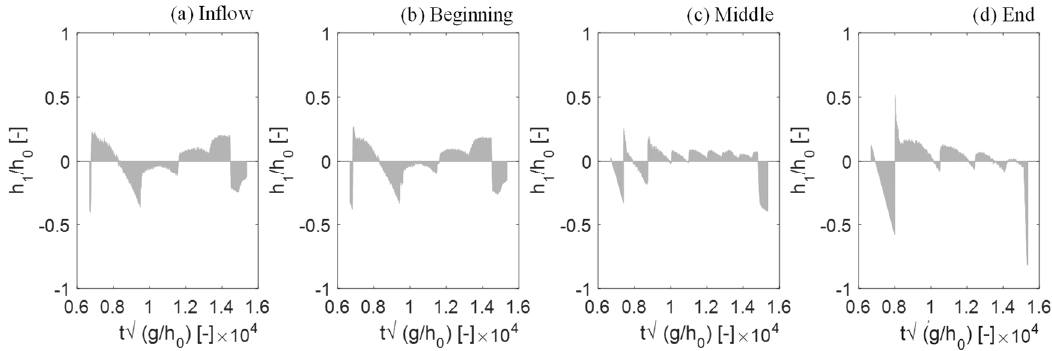
Figure 11. Deviation of measured water level ratios and time-dependent mean value ratios for the single-channel model.